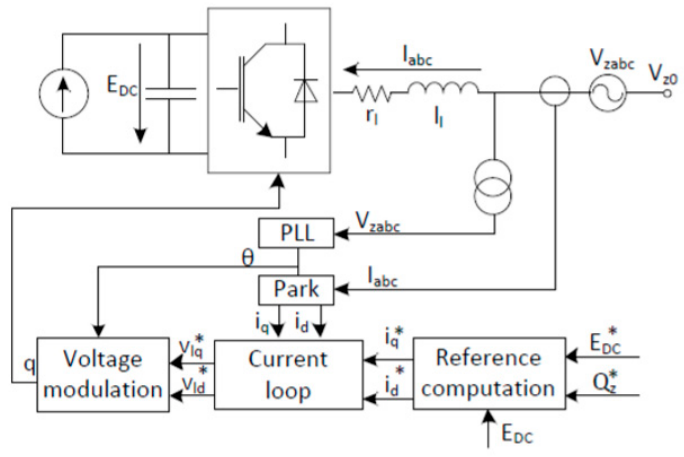
Figure 12. voltage source control (VSC) scheme.